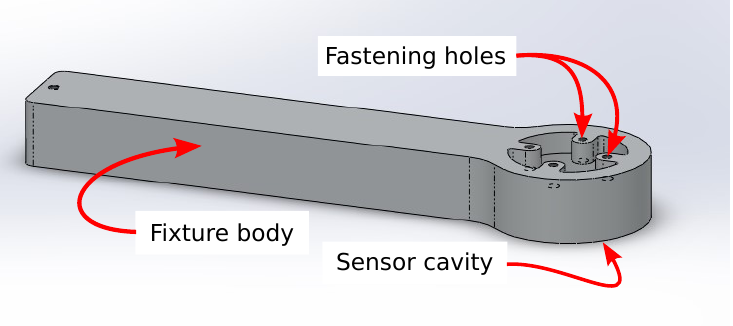
Figure 2. The aluminum fixture that fits and grounds the 3-DOF sensor. The sensor is secured to the fastening holes from within the sensor cavity. The long fixture body allows large-scale adjustment of the sensor to accommodate the user’s unique neutral hand posture.